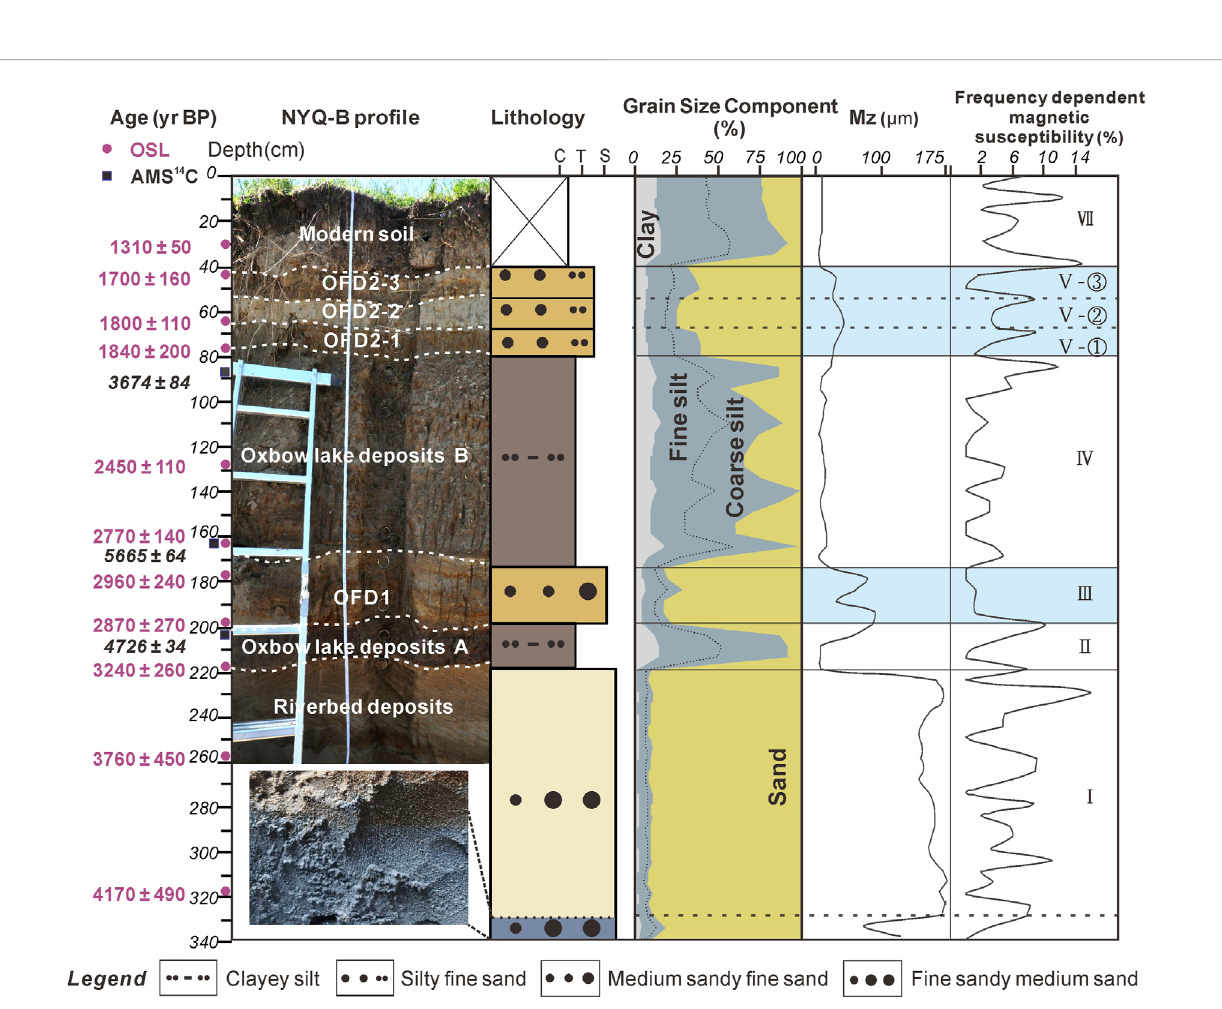
FIGURE 3 Sedimentary framework of the paleo-oxbow lake fi ll at NYQ-B site within the Zoige Basin on the NE Tibetan Plateau, including lithology, dating results,grainsizeparameters,magneticsusceptibilityandfrequencydependentmagneticsusceptibility.TheresultsofAMS 14 CandOSLdatinginFigure3 refer to Xiao et al.,